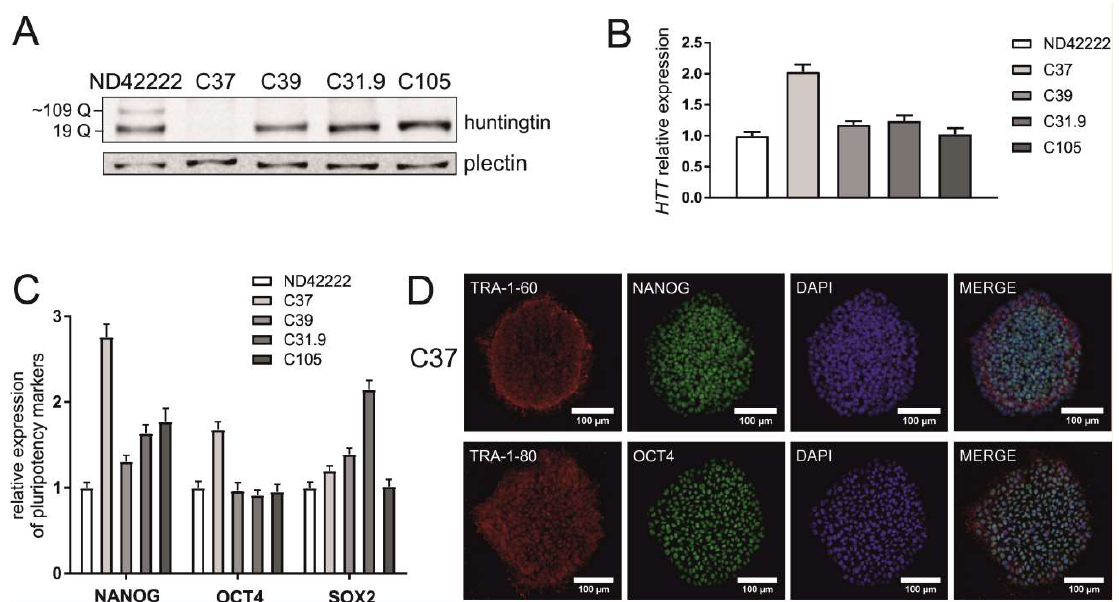
Figure 2. Characteristics of isogenic hiPSC clones. ( A ) Huntingtin protein level in HD hiPSC line with 19 / 109 Qs and its isogenic control cell lines was analyzed by western blotting. Plectin was used as a reference protein. ( B ) Analysis of the relative expression of the HTT gene by RT-qPCR in parental hiPSCs and generated cell lines. ( C ) The gene-edited hiPSCs maintain pluripotency as shown by expression of NANOG , OCT4 and SOX2 genes and ( D ) positive immunostaining for the pluripotency markers (presented for the C37 clonal cell line). The RT-qPCR results indicate the mean ( ± SEM) relative to expression level in ND42222, set at 1. ND42222 – parental HD hiPSCs; isogenic cell lines: C37 – HTT_KO hiPSCs, C39 – HD_19 / 19mut hiPSCs, C31.9 and C105 - HD_19 / 19